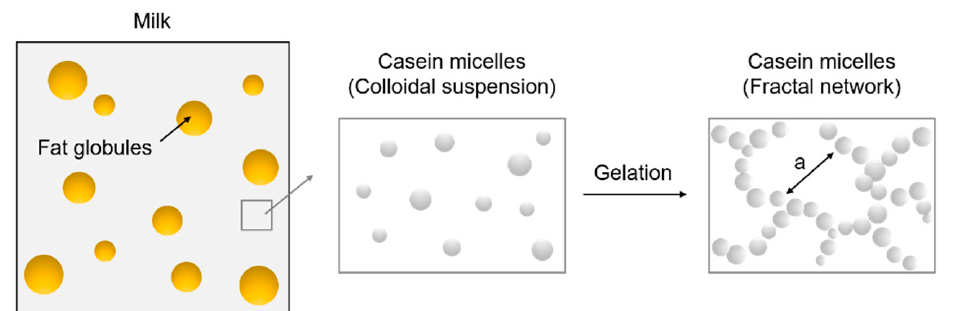
Figure 3. Schematic representation of the milk structure (fat globules and casein micelles) and the gelation